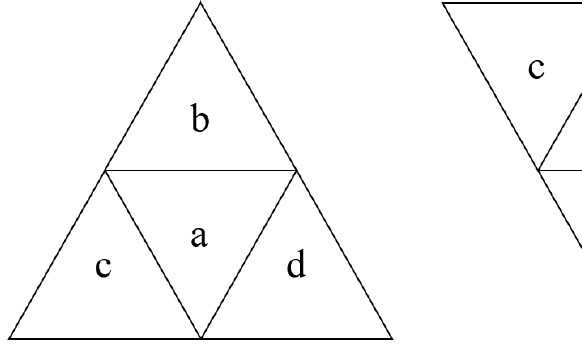
Figure 8. The direction encoding.